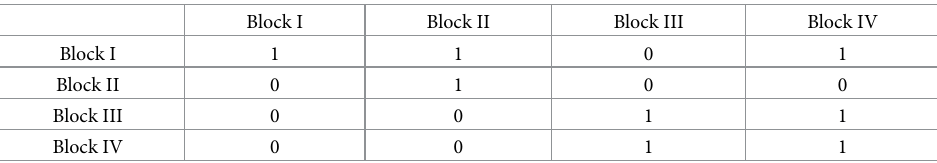
Table 14. Image matrix of